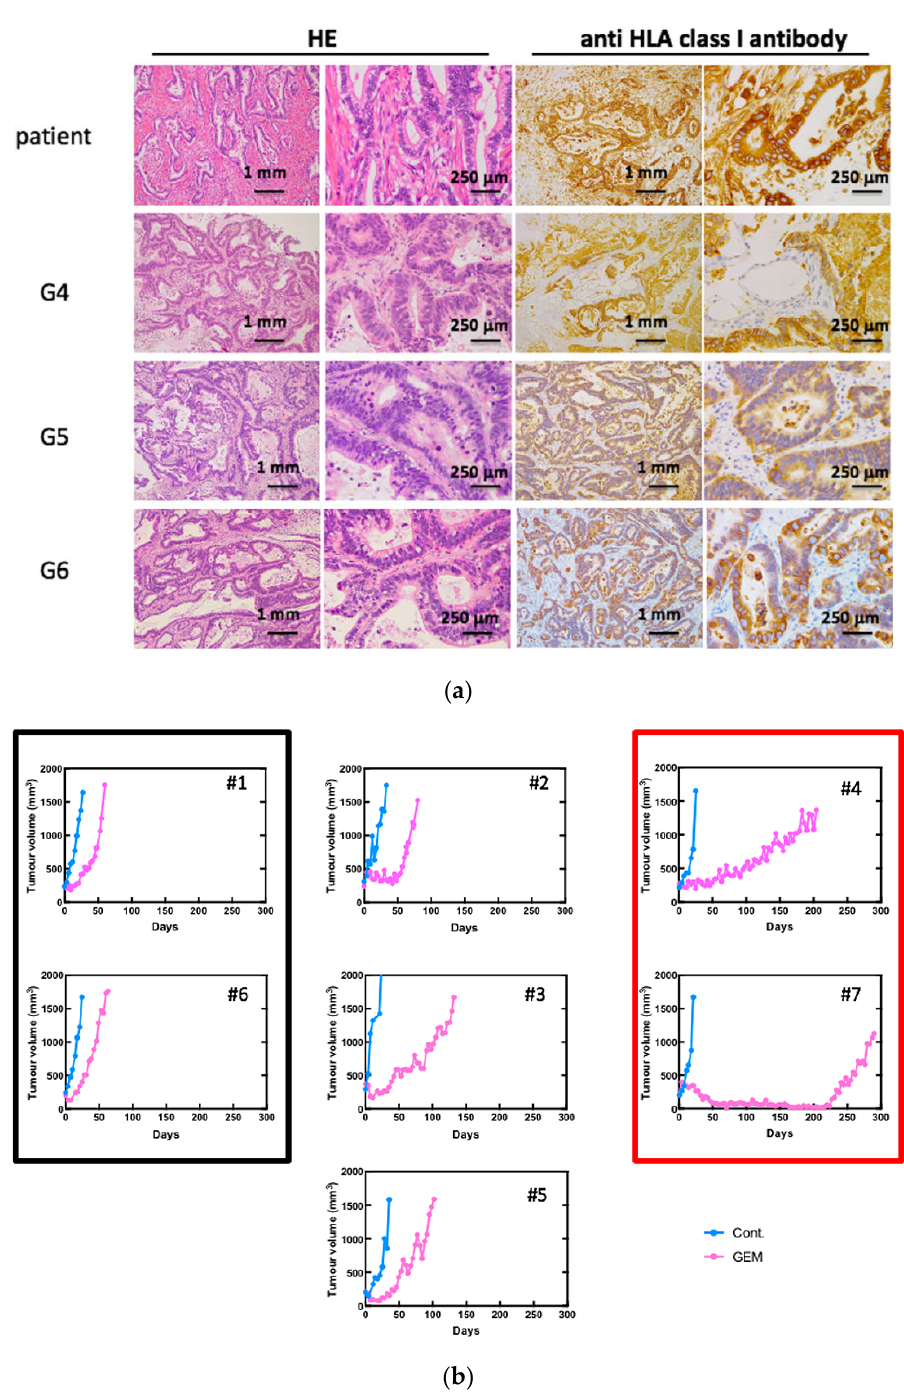
Figure 1. Gemcitabine (GEM)-treated pancreatic cancer patient-derived xenograft (PDX) mice. ( a ) Establishment of PDX mice. Morphological characteristics were well preserved in xenograft tumors in NSG mice even at G6. Hematoxylin and eosin (H&E) staining and immunohistochemistry for anti-HLA class I antibody are shown. ( b ) Tumor growth curve after treatment of GEM. Seven PDX lines were treated with GEM after tumor volume exceeded 200 mm 3 . Different PDXs had different sensitivities for GEM. PDX mice that had high sensitivity for GEM are in the red box, and those with low sensitivity are in the black box. #1–#7 is shown as the name of the xenograft.